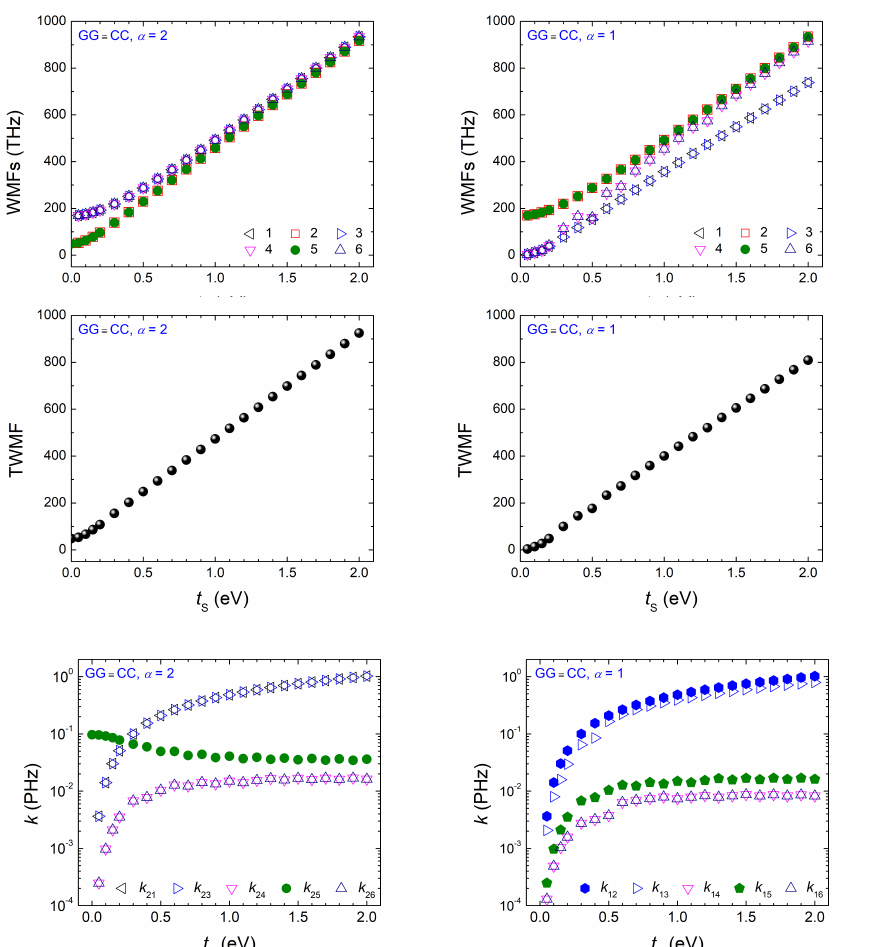
Figure A1. A dimer made of identical monomers and purine on purine: GG ≡ CC. Initial oxidation occurs either at the first base pair ( α = 2, left column ) or at the first deoxyribose ( α = 1, right column ). The mean-over-time probabilities to find the hole at each dimer site (first row), WMFs of all sites (second row), TWMF (third row), and transfer rates from site to site are presented as functions of t S .